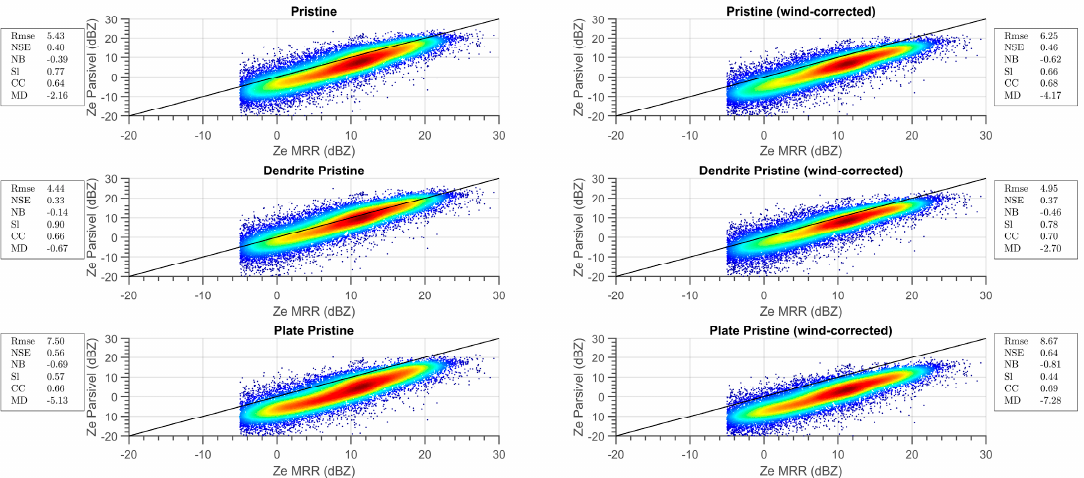
Figure 5. Same as Figure 4 but for the three categories of pristine